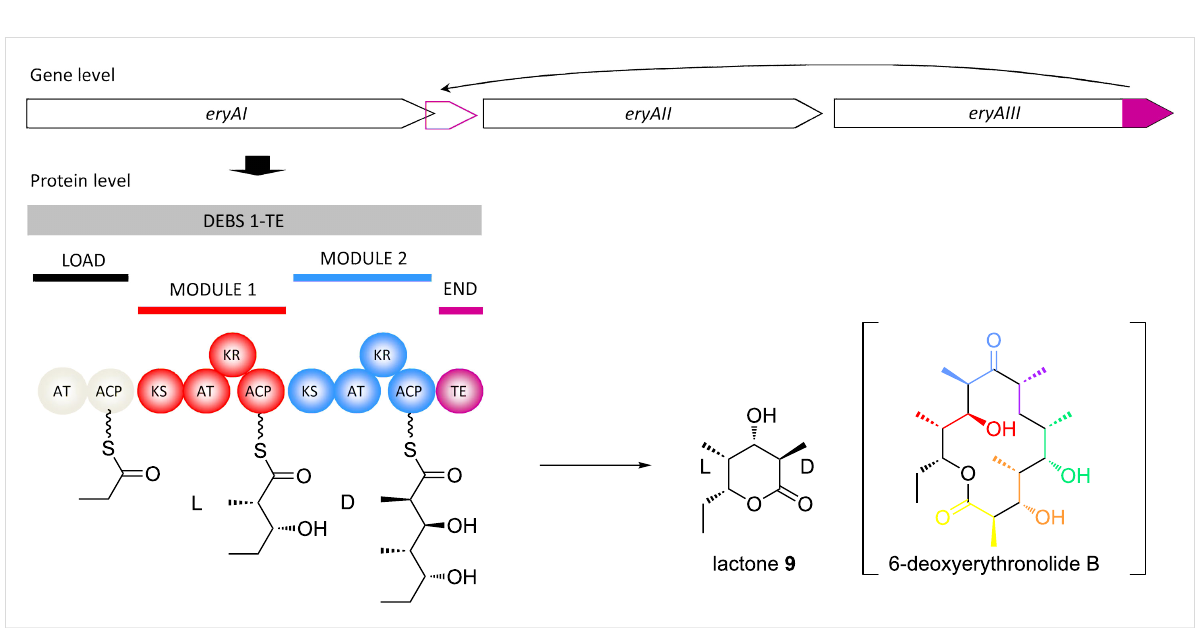
Figure 6: Creation by genetic engineering of the DEBS 1-TE model system. The region of the eryAIII gene encoding the thioesterase (pink) was relo- cated to the end of gene eryAI . The resulting protein, DEBS 1-TE, produces a small triketide lactone 9 instead of the heptaketide 6-deoxyerythrono- lide B. The two methyl centers in lactone 9 are of opposite stereochemical configuration, and thus DEBS 1-TE is an attractive protein for studying the control of stereochemistry.